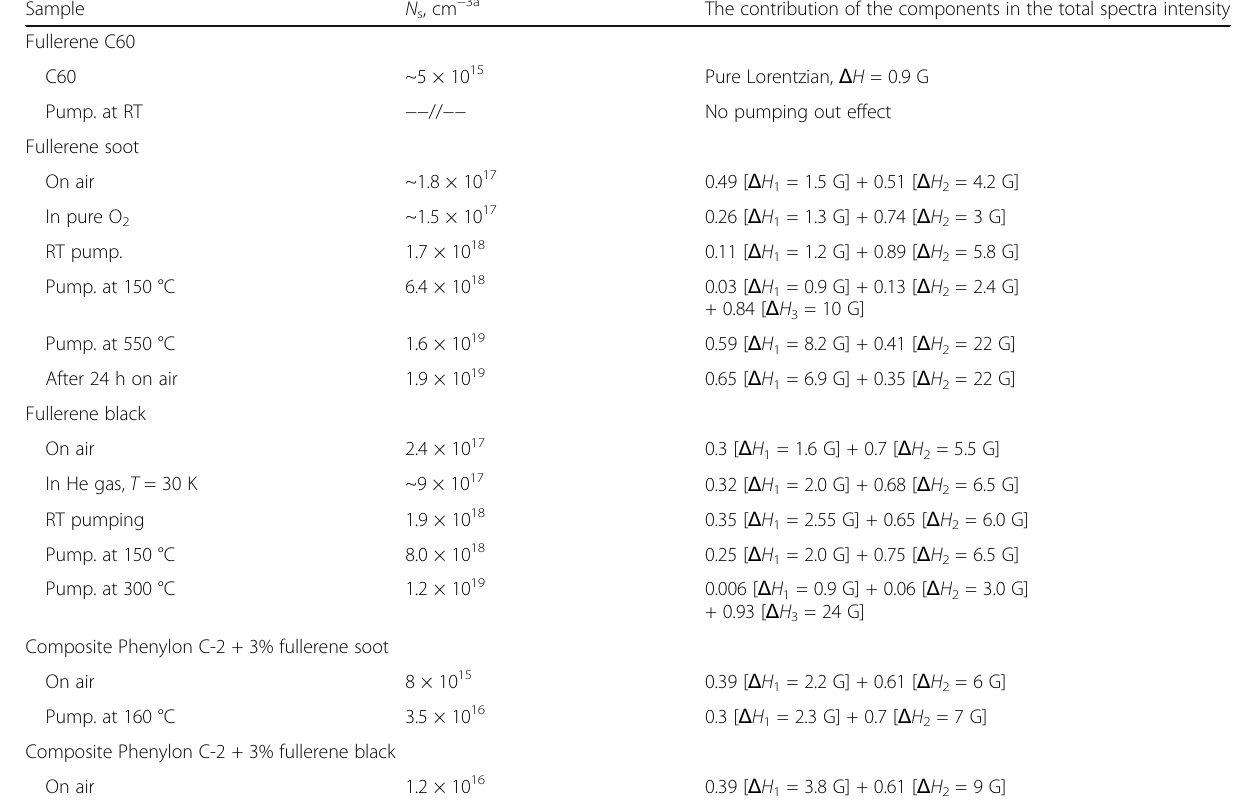
Table 1 EPR characteristics of studied